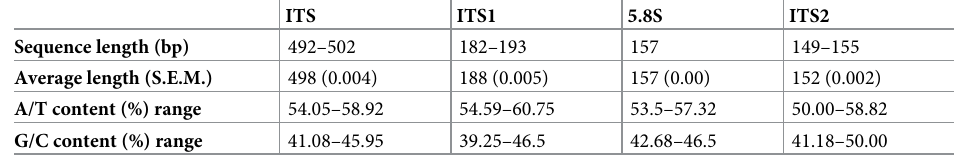
Table 1. Characterization of the ITS region and their constituents ITS1, 5.8S and ITS2 from Ampelomyces spp. ITS